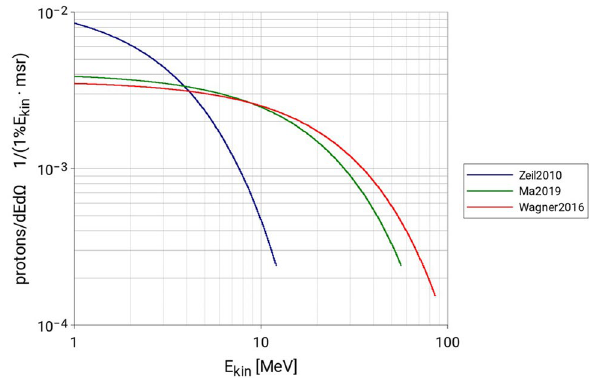
Figure 4. Proton spectra (normalized to integral = 1) used as input parameter for the LION-Geant4 simulations.